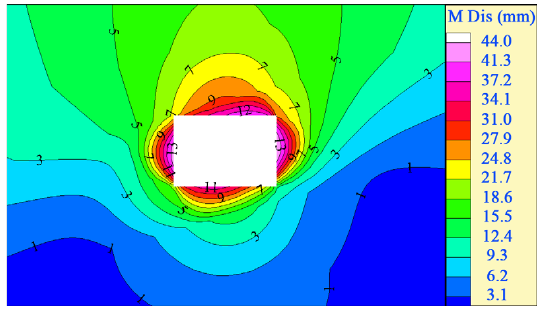
Figure 15. Line chart of X -axis stress of the roadway floor. The stress value of the roadway floor in the inclined coal seams decreases with the increased inclination angle, and the maximum stress value shifts to the lower side of inclined rock strata. The maximum floor stress offsetting the centerline increases with the increased inclination angle of the coal seam. The maximum stress is about 1 m away from the roadway centerline, so it is most suitable for the pressure-relief groove to be 1 m away from the centerline of the roadway floor.